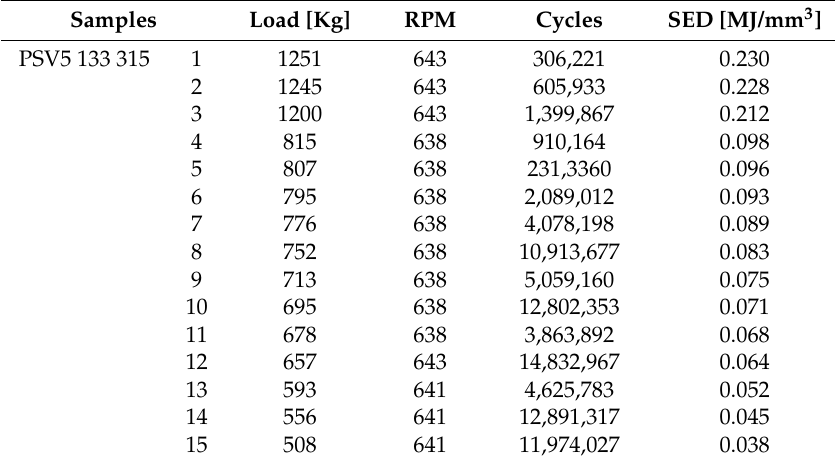
Table 7. Fatigue data for the roller PSV5 133 315.